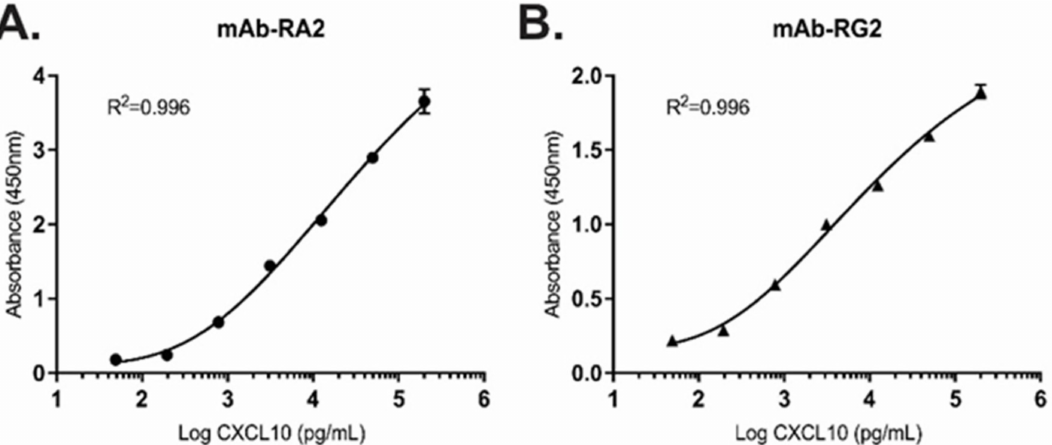
Figure 1. Representative standard curves for the detection of recombinant, full-length CXCL10 using ( A ) mAb-RA2 and ( B ) mAb-RG2 in the range 49–200,000 pg mL − 1 . Mean +/ − SD; triplicate measurements per data